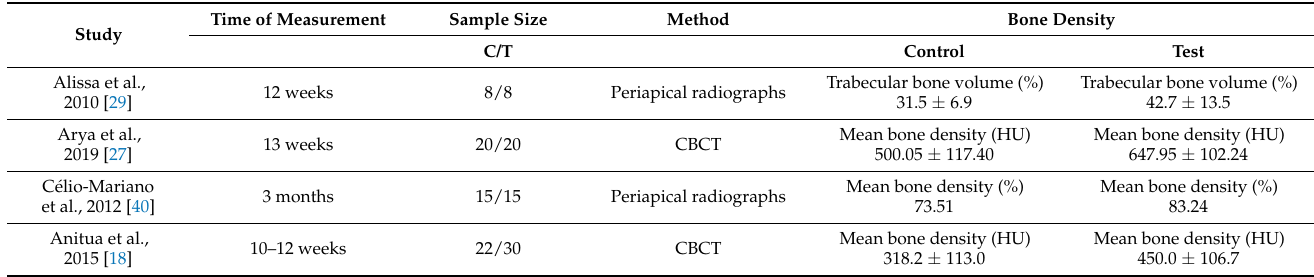
Table 3. Bone density measurements of the included studies.